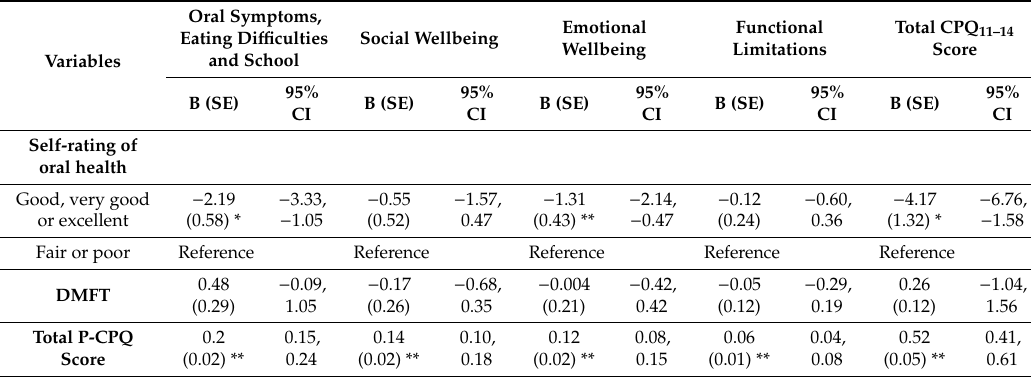
Table 5. Multiple linear regression analysis with the subscale and overall Hindi CPQ 11–14 scale as the dependent variables (adjusted for age and